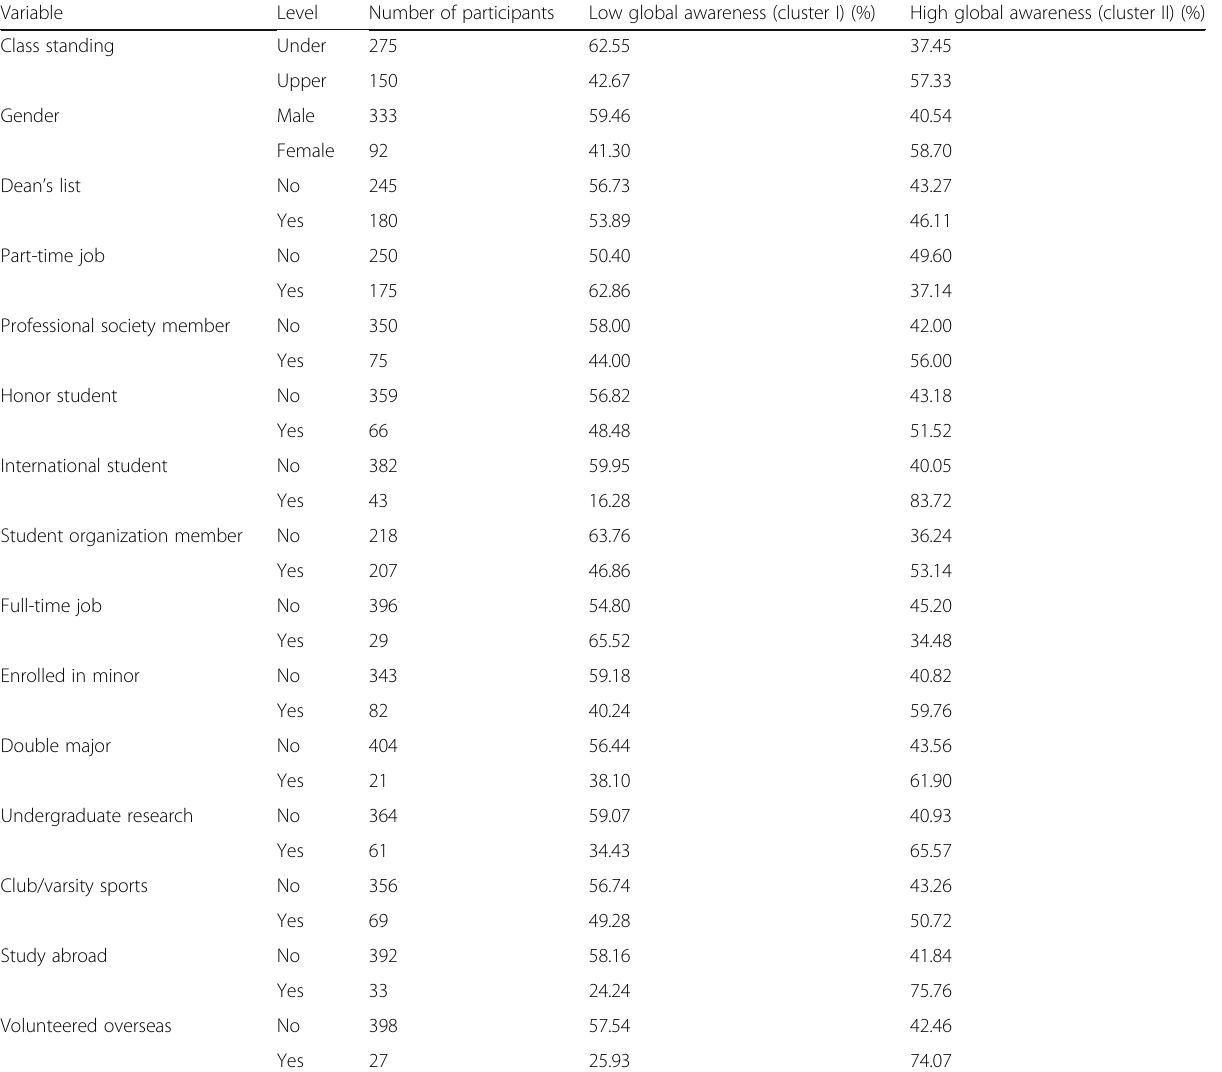
Table 8 Demographic and academic characteristics of students classified as low (cluster I) or high (cluster II) global awareness Variable